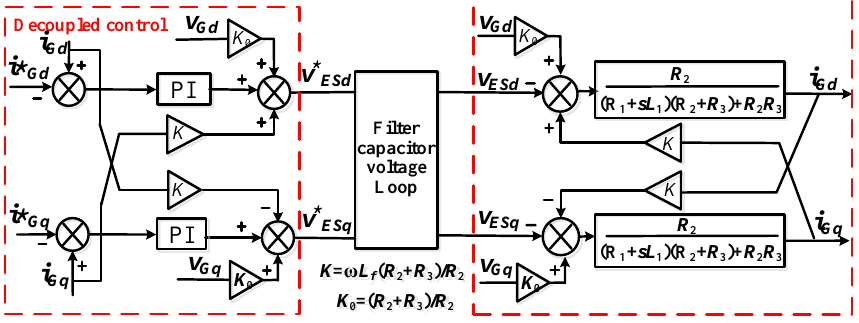
Figure 4. Current loops of primary control for ES-2.